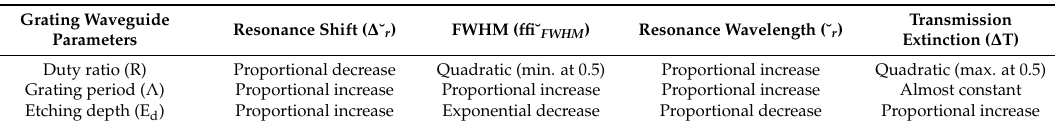
Table 1. Relationship between grating waveguide parameters and transmission extinction